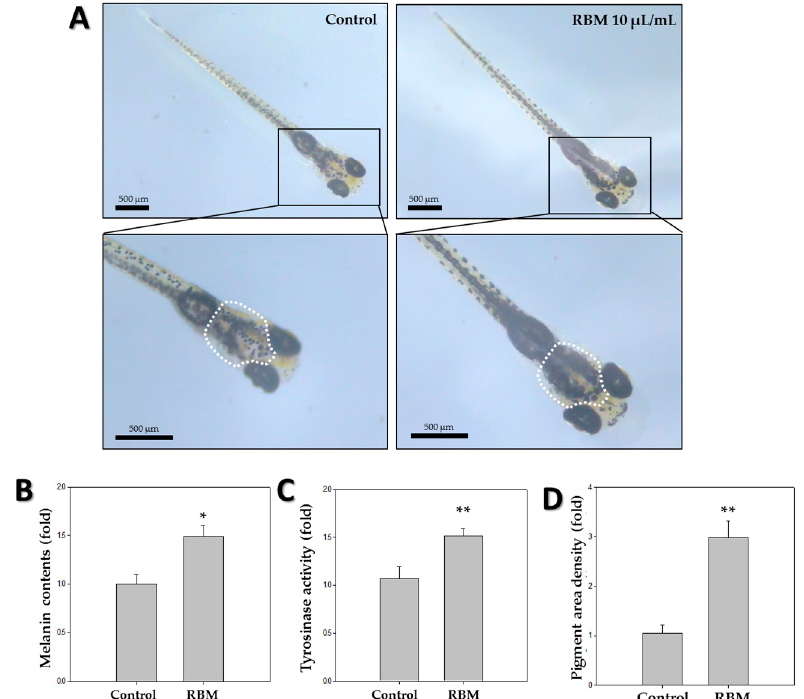
Figure 2. Effects of rice bran ash mineral extract (RBM) on pigmentation in zebrafish. ( A ) Synchronized zebrafish embryos ( n = 20) were exposed to RBM, and pigmentation was observed under a stereomicroscope via inferior views of the embryos at 5 dpf; ( B ) Zebrafish melanin content was detected by melanin content assay at 5 dpf ( n = 80); ( C ) Tyrosinase activity in zebrafish ( n = 80) was detected by tyrosinase assay at 5 dpf; ( D ) Pigmentation density in the indicated white-outlined area was measured in treated embryos and normalized to that of control embryos using the software ImageJ. * p < 0.05, ** p < 0.01, compared to control. Scale bar; 500 µm.